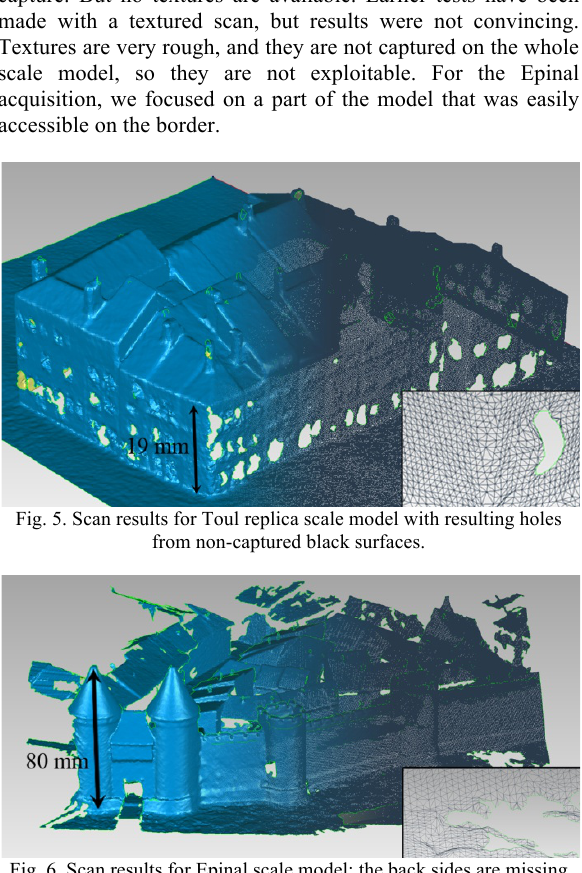
Fig. 6. Scan results for Epinal scale model: the back sides are missing because it is not accessible by the